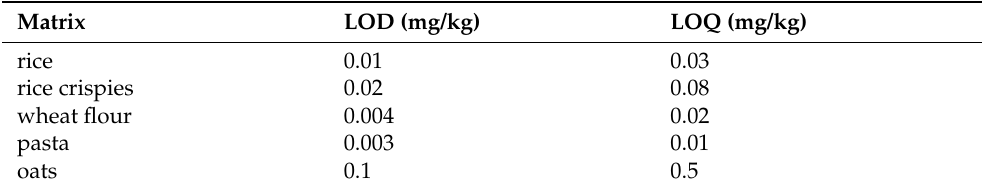
Table 2. LOD and LOQ derived for CIT quantification by MISPE using bulk MIP imprinted by RHO (following DIN 32645 [34] using a matrix-matched five point calibration, n = 3).